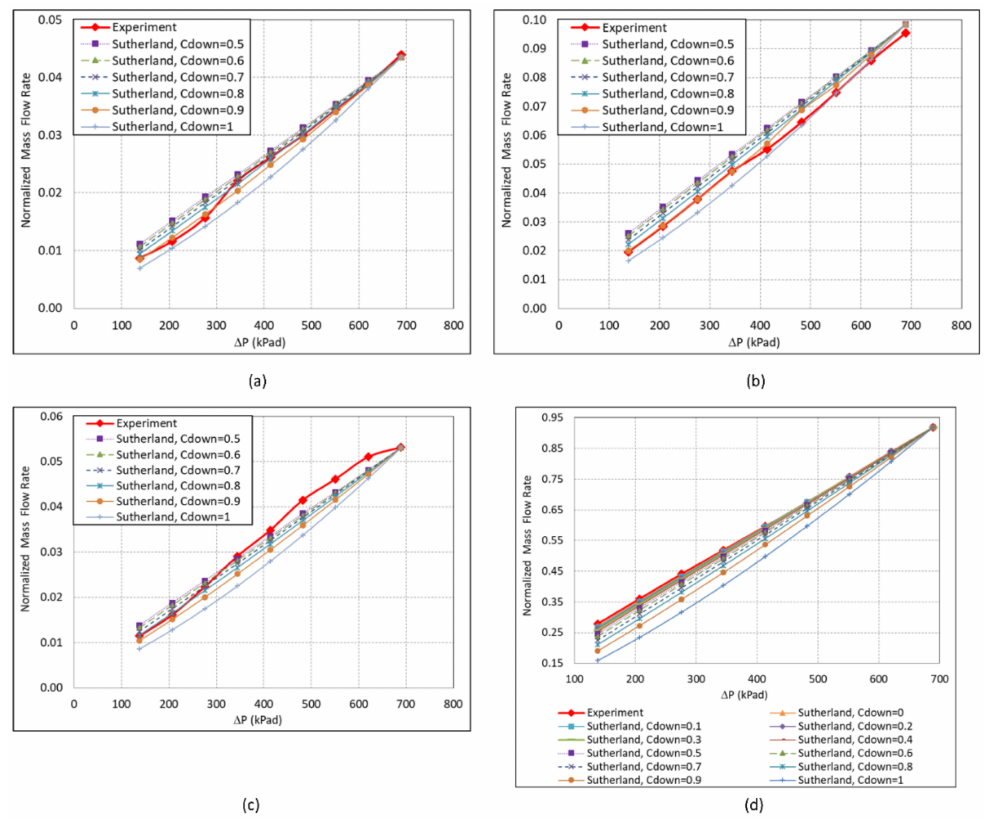
Figure 13. Comparison of CFD and test results for various pressure constant ( C down ) values: ( a ) warp direction, ( b ) shute direction, ( c ) diagonal direction, and ( d ) cross